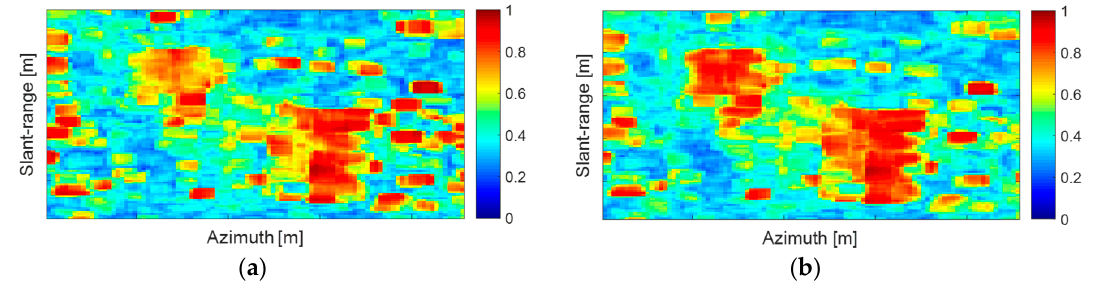
Figure 6. Average coherence ( a ) single polarization, ( b ) dual polarization.